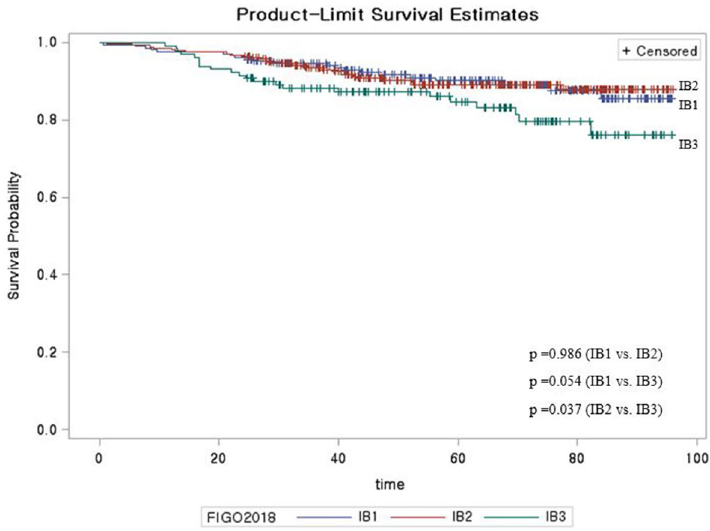
Figure 1. Kaplan–Meier analysis of survival for 2018 FIGO stages IB1/IB2/IB3.